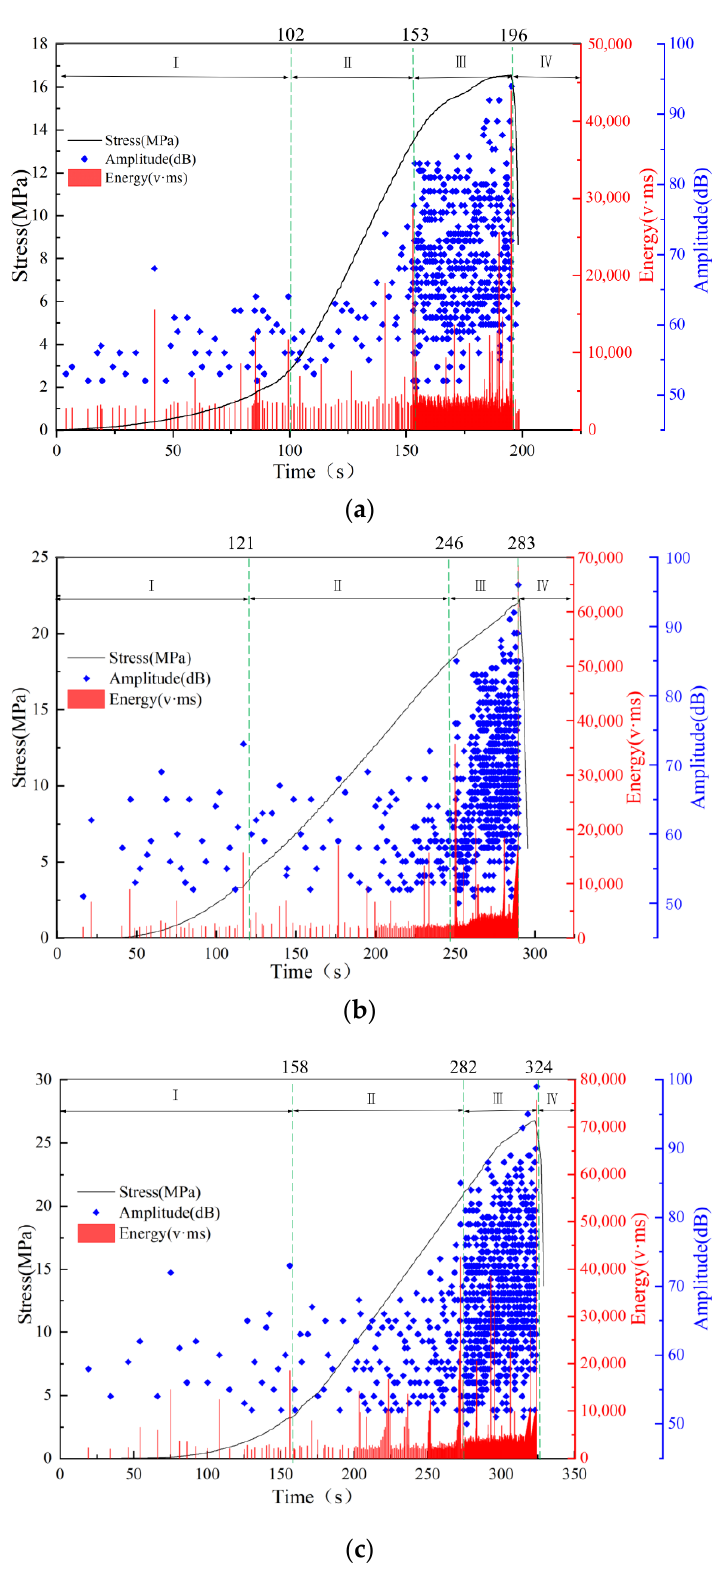
Figure 4. Stress–time–energy–amplitude curve during fracture evolution, ( a ) Sample CSAS-1 Stress–time–energy–amplitude curve; ( b ) Sample CSAS-2 Stress–time–energy–amplitude curve; ( c ) Sample CSAS-3 Stress–time–energy–amplitude curve.